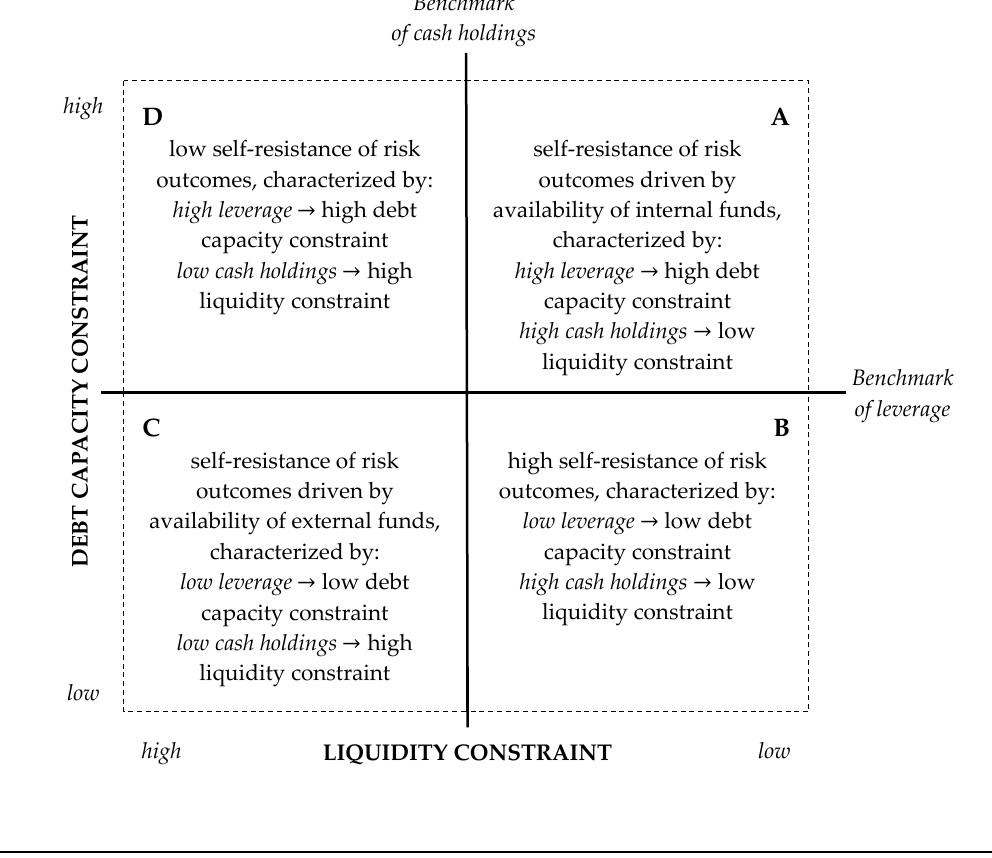
Figure 1. Conceptual model of four patterns of self-resistance to risk outcomes.